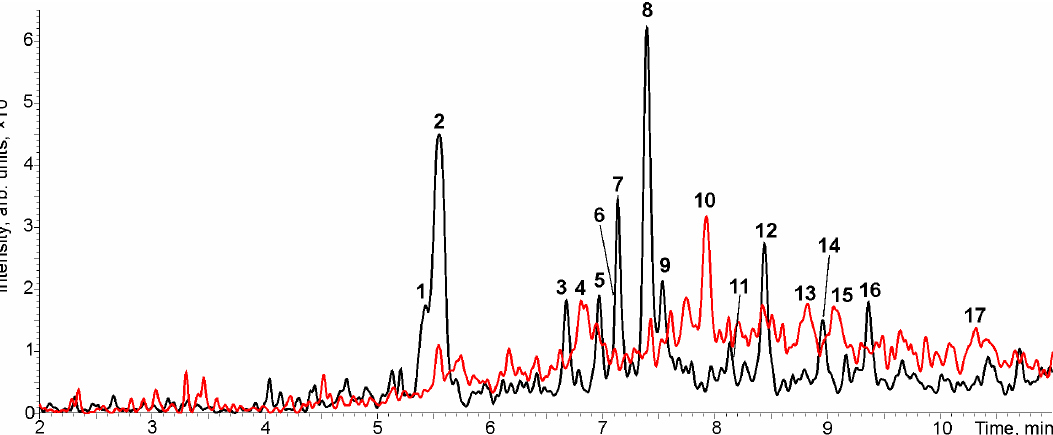
Figure 4. The HPLC-MS/MS chromatogram of urban wastewater obtained in PrecIS mode using a product ion with m / z 174 (red) and a product ion with m / z 158 (black).